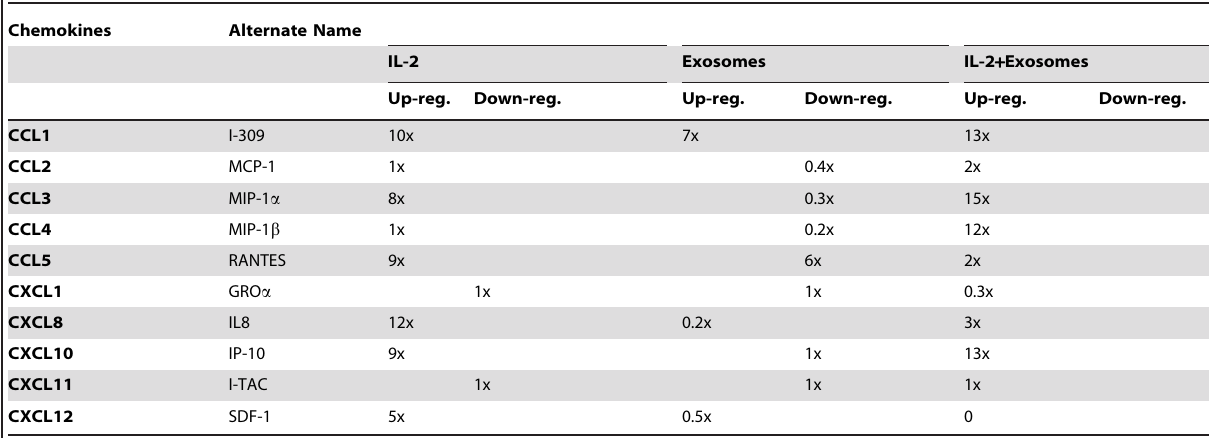
Table 2. Human cytokine array